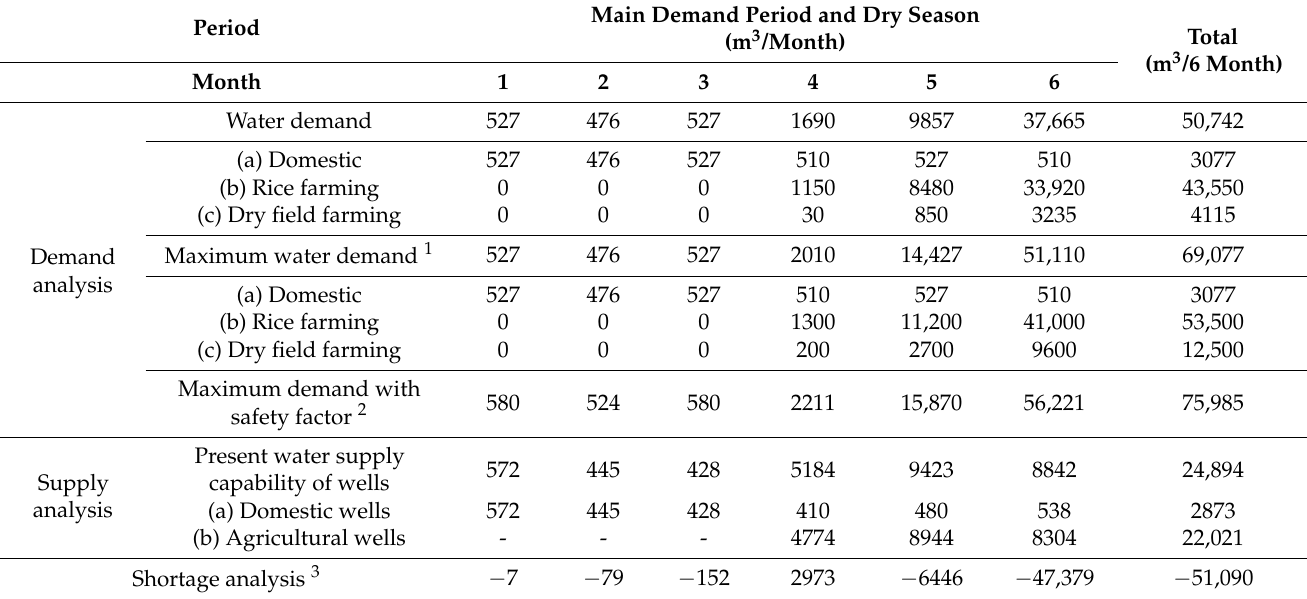
Table 1. Analysis of water shortage from January to June in the study area (modified from